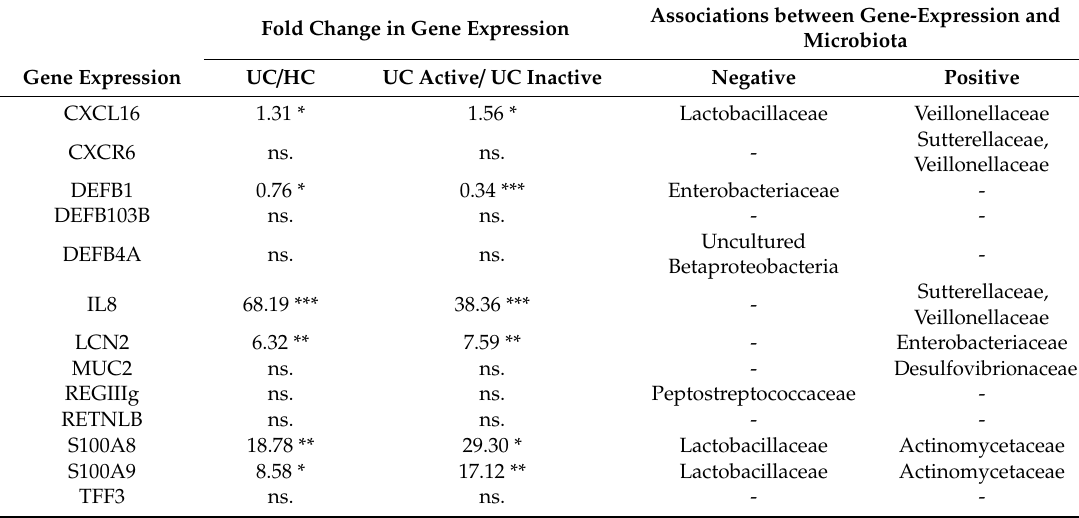
Table 3. Expression of selected genes and their associations with bacterial